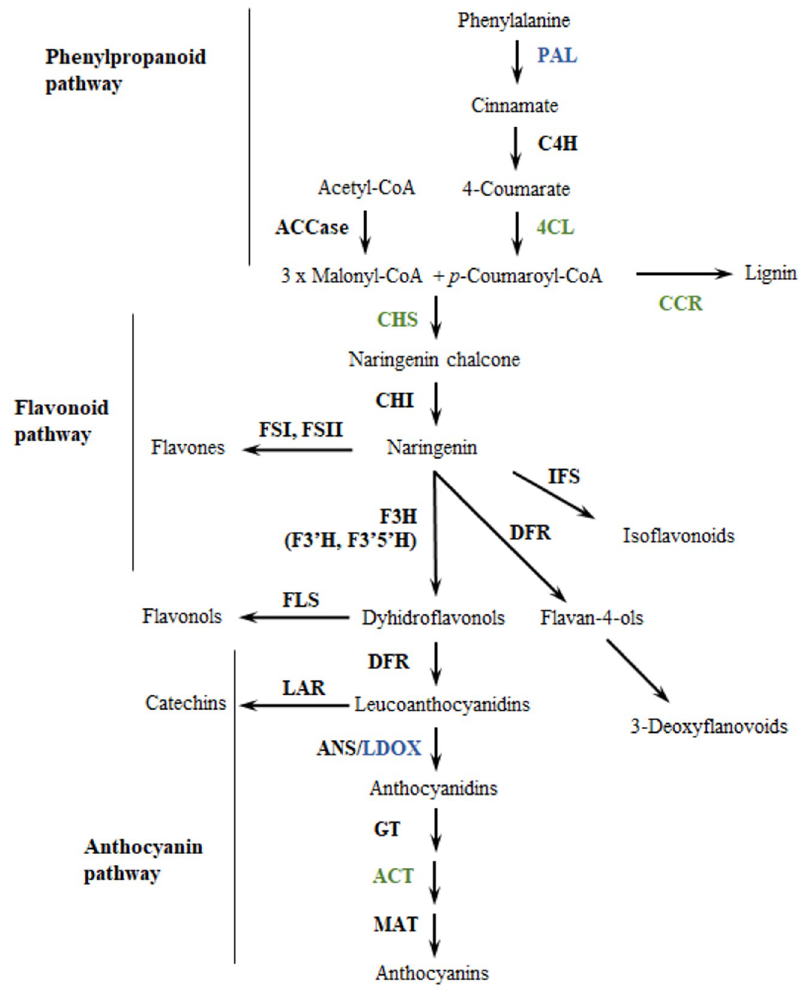
Fig 1. Enzymes from the phenylpropanoid pathway associated to anthocyanin variation in a population of Solanum tuberosum group Phureja. Enzymes in green correspond to genes identified in the gene-set analysis. Enzymes in blue correspond to genes identified in GWAS and gene-set analysis. Enzyme abbreviations: ACCase: acetyl-CoA carboxylase; PAL: phenylalanine ammonia-lyase; C4H: cinnamate 4-hydroxylase; 4CL: 4-coumarate:CoA ligase; CCR: cinnamoyl CoA reductase; CHS: chalcone synthase; CHI: chalcone isomerase; FS: flavone synthase; IFS: isoflavone synthase; F3H: flavanone 3 β -hydroxylase; F3’H: flavonoid 3’-hydroxylase; F3’5’H: flavonoid 3’,5’- hydroxylase; FLS: flavonol synthase; DFR: dihydroflavonol 4-reductase; LAR: leucoanthocyanidin reductase; ANS: anthocyanidin synthase; GT: glucosyltransferase; ACT: anthocyanin acyltransferase; MAT: malonyltransferase. Modified from Springob